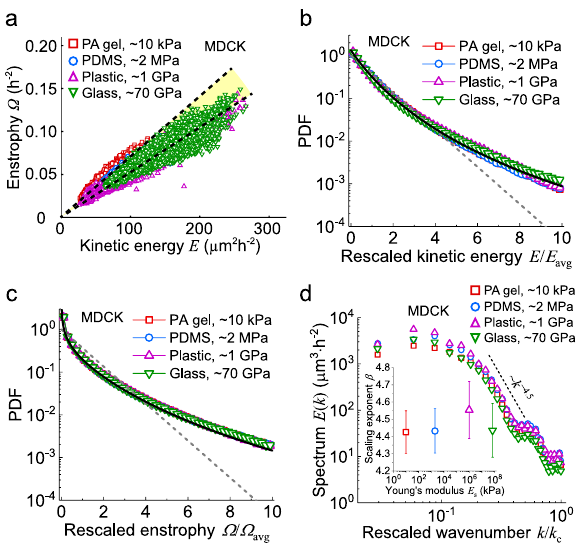
Fig. 3 Energetic statistics of mesoscale cell turbulence in monolayers of different cell types. a The enstrophy scales linearly with the kinetic energy over time. Different symbols refer to different cell types: red squares for Madin Darby canine kidney cells (MDCK); blue circles for human umbilical vein endothelial cells (HUVEC); purple upward-pointing triangles for C2C12 mouse myoblast cells (C2C12); and green downward-pointing triangles for NIH-3T3 mouse embryo fi broblast cells (NIH-3T3). For each cell type, data were collected from eight independent fi eld of views (FOVs) and four independent samples. The dashed lines represent linear fi ttings to Ω ¼ E = ξ 2 with the characteristic length scales ξ a ; MDCK (cid:3) 44 : 1 μ m for MDCK and a ξ (cid:3) 30 : 7 μ m for HUVEC. The yellow sector represents the data set a ; HUVEC area bounded by MDCK and HUVEC. b , c Representative probability density functions (PDFs) of b the rescaled kinetic energy and c the rescaled enstrophy. Values are rescaled by their average. The gray dashed curves represent the Maxwell – Boltzmann distribution, while the black solid curves refer to the fi ttings to q -Gaussian distributions (Eq. (2) for b and Eq. (4) for c ) with the Tsallis index q ¼ 1 : 2. d Representative energy spectra E ( k ). k c represents the wavenumber at the scale of one cell. Inset: the scaling exponent β for each cell type (symbols refer to different cell types). Error bars: mean ± SD (for each cell type, data were collected from eight independent FOVs and four independent samples).